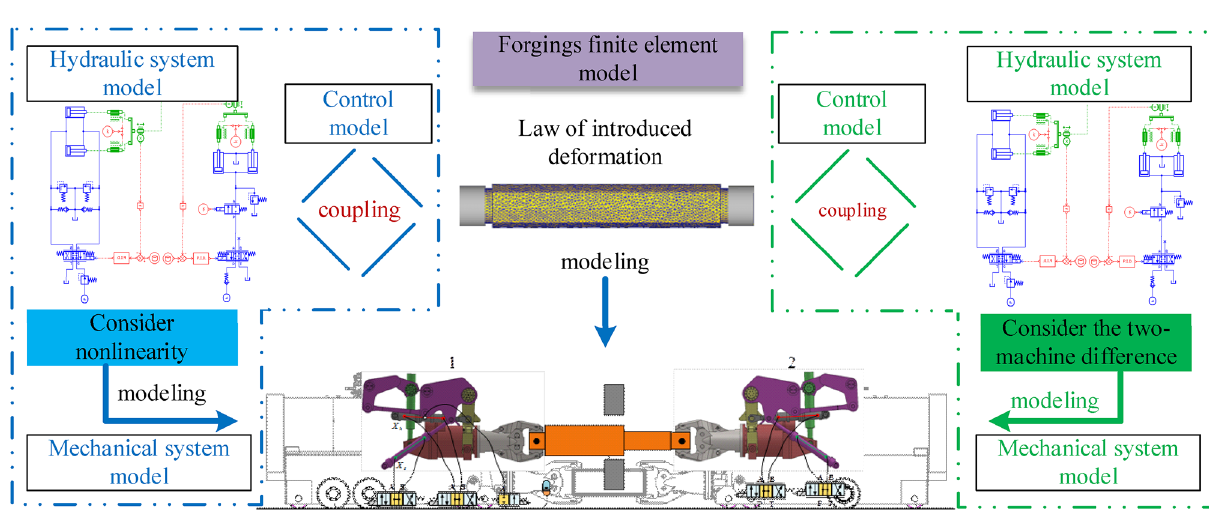
Figure 7. Simulation model of dual forging manipulator’s synchronous